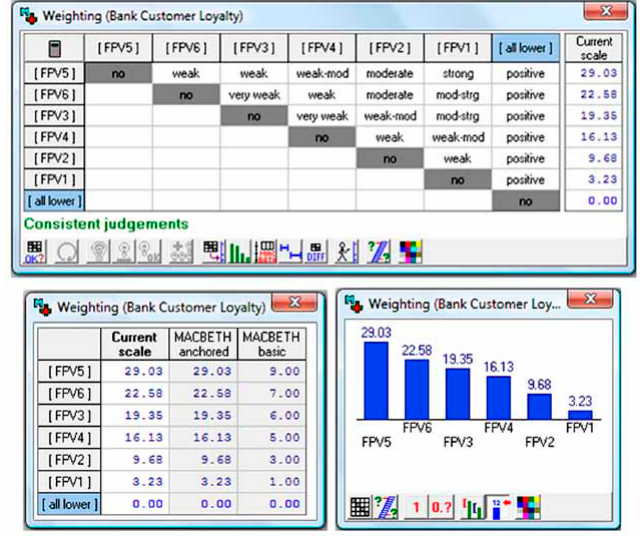
Fig. 4. Criteria weights